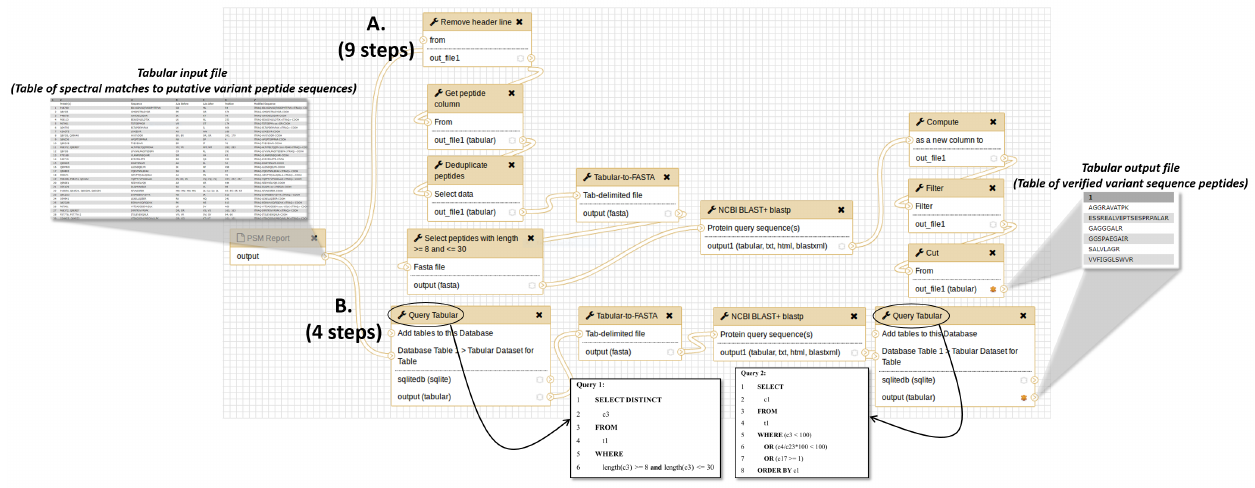
Figure 2. A proteogenomics workflow using Query Tabular. This workflow takes as input peptide spectrum matches (PSMs) of putative variant peptide sequences and further analyzes them using BLASTP to verify sequences which are truly variants compared to the